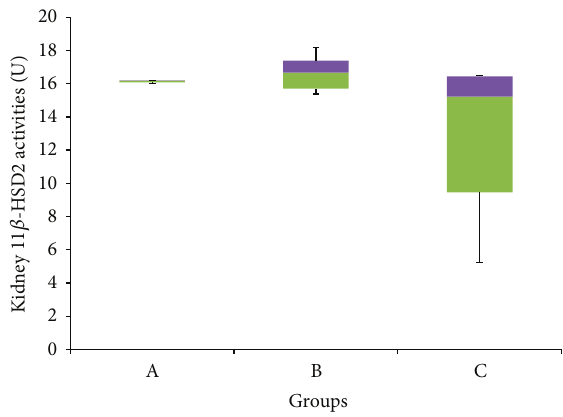
Figure 10: 11 𝛽 -HSD 2 activities in the kidney of rats in group A, B and C at the end of the four-week treatment period. Group A: control (HSD/HFD); group B: stress + HSD/HFD; group C: stress+GA+HSD/HFD. Abbreviations: GA: glycyrrhizic acid, HSD: high-sucrose diet, and HFD: high-fat diet.